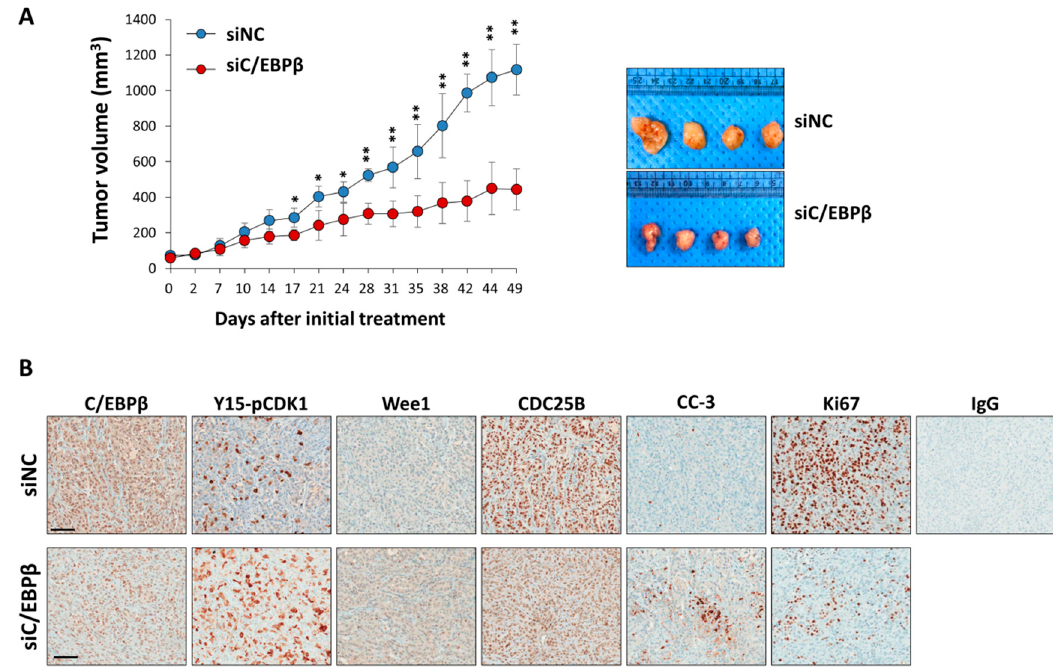
Figure 7. C/EBP β -knockdown inhibits tumor growth. ( A ) A549 cells (5 × 10 6 ) were implanted subcutaneously into athymic nude mice. When tumor size reached 60 to 80 mm 3 , siNC or siC/EBP β were delivered into the tumors via electroporation once a week for seven weeks. Tumors were measured at the indicated time and tumor volume was calculated as described in Section 2. Photos from siNC- or siC/EBP β -treated tumors are shown. Similar results were observed in three independent experiments. Data are presented as mean ± SD. The statistical significance was determined using the t -test, * p < 0.05, ** p < 0.01, significantly different from siC/EBP β -treated tumor volume. ( B ) Immunohistochemical staining for C/EBP β , Y15-pCDK1, Wee1, Cdc25B, Ki67, and cleaved caspase-3 (CC-3) was conducted with paraformaldehyde-fixed, paraffin-embedded xenograft tumors. Images were captured at a magnification of 400X by using the Aperio ImageScope software. Scale bars: 100 μ m.